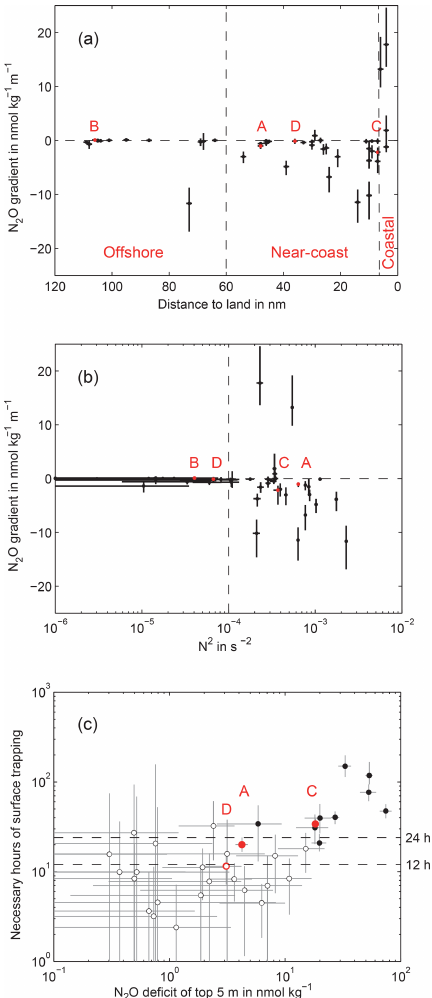
Figure 5. Characteristics of shallow N 2 O gradients derived from shipboard samples. The N 2 O gradient is calculated from bottle sam- ples at about 5m and about 10m depth; negative gradients are de- fined as concentration decreasing with vertical coordinate z or in- creasing with depth. Error bars are 95% confidence limits based on measurement uncertainty. Red symbols are high-resolution stations A to D (see Figs. 1 and 4). (a) N 2 O gradient vs. distance to land, calculated as shortest distance to coast. Dashed vertical lines sepa- rate three zones (offshore, near-coast, coastal), dominated by neu- tral, downward, and upward gradients, respectively. (b) N 2 O gradi- ent vs. buoyancy frequency squared, N 2 , calculated from densities of the corresponding N 2 O bottle samples. The dashed vertical line at N 2 =10 − 4 s − 2 marks the approximate threshold below which no strong N 2 O gradients occur. (c) N 2 O deficit vs. estimated necessary time span of surface trapping, N 2 O deficit is concentration differ- ence between 10 and 5m; hours of isolation are the time needed to deplete a 5m water column from the 10m concentration down to the 5m concentration. Filled circles are stations where the neces- sary isolation time includes minimum one entire night, even for the lower confidence limit. Open circles are stations where night mix- ing cannot be excluded. Station B showed no negative gradient and is not part of the